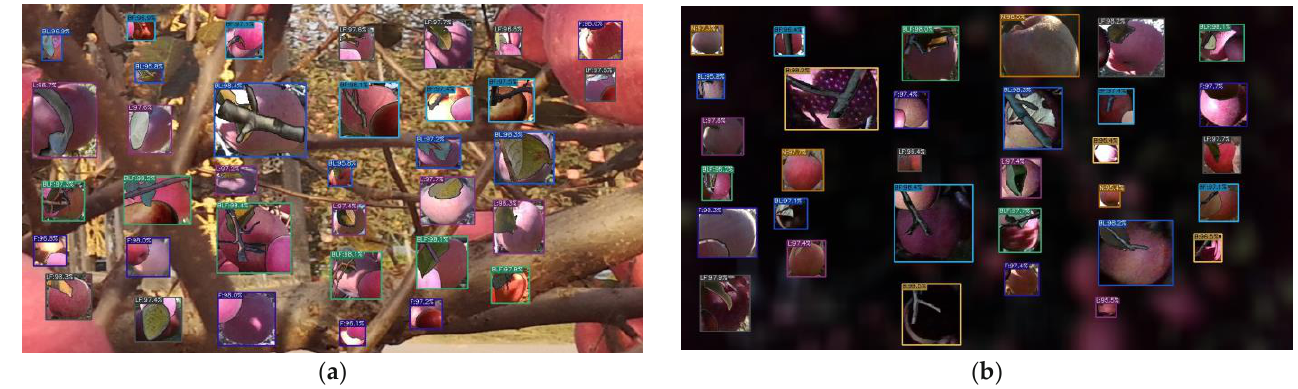
Figure 9. Synthesis image in high and low illuminations: ( a ) Synthesis image in high illumination; ( b ) Synthesis image in low illumination. Table 4. Synthesis results of basic training dataset by high and low illumination.